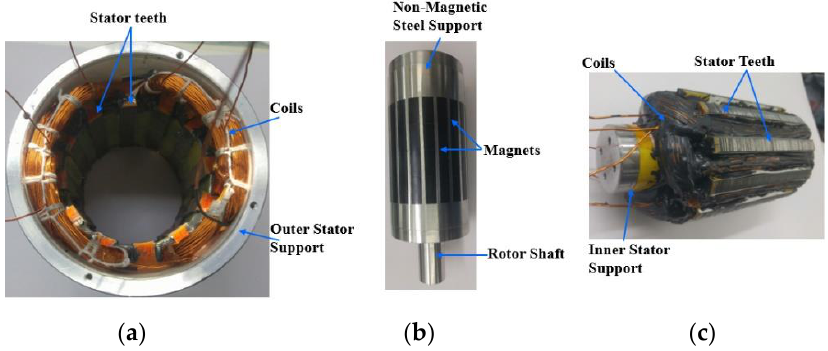
Figure 15. Prototype of proposed machine: ( a ) outer stator, ( b ) yokeless rotor, ( c ) inner stator.